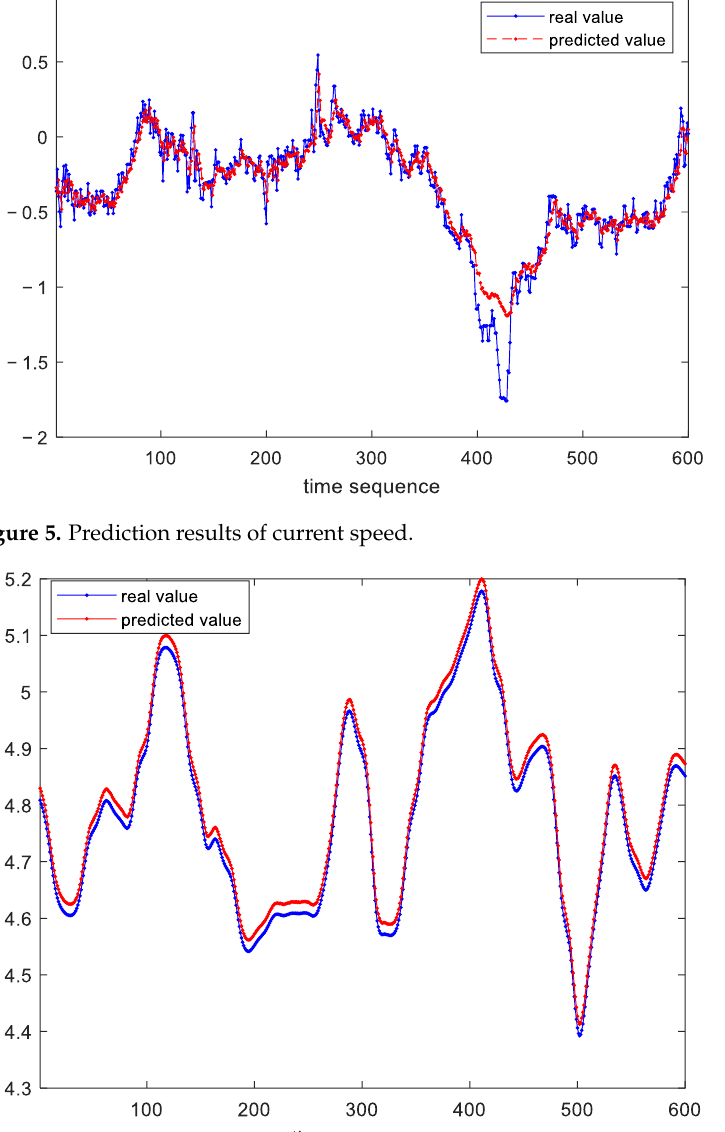
Figure 6. Prediction results of ship speed.